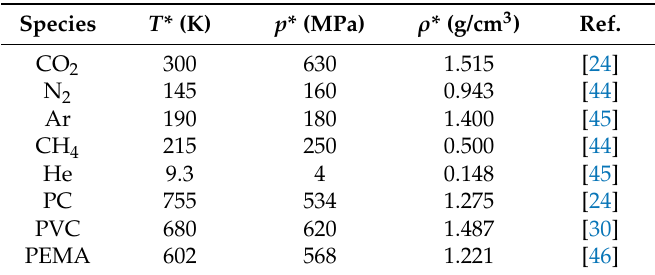
Table 1. Characteristic parameters of the lattice fluid EoS/nonequilibrium LF model.